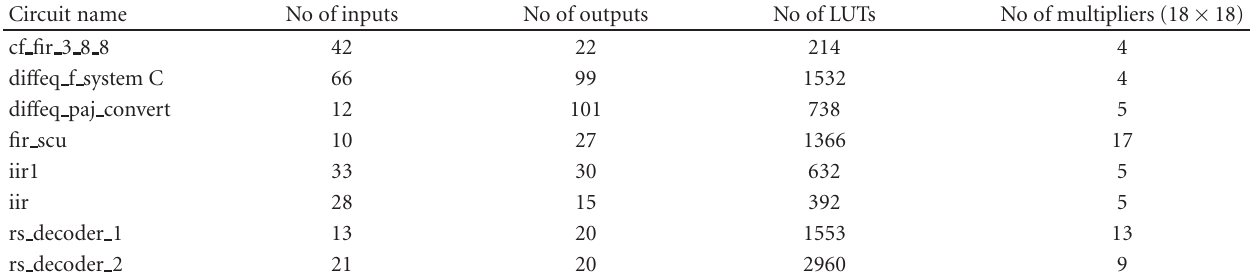
Table 3: Open core benchmarks set